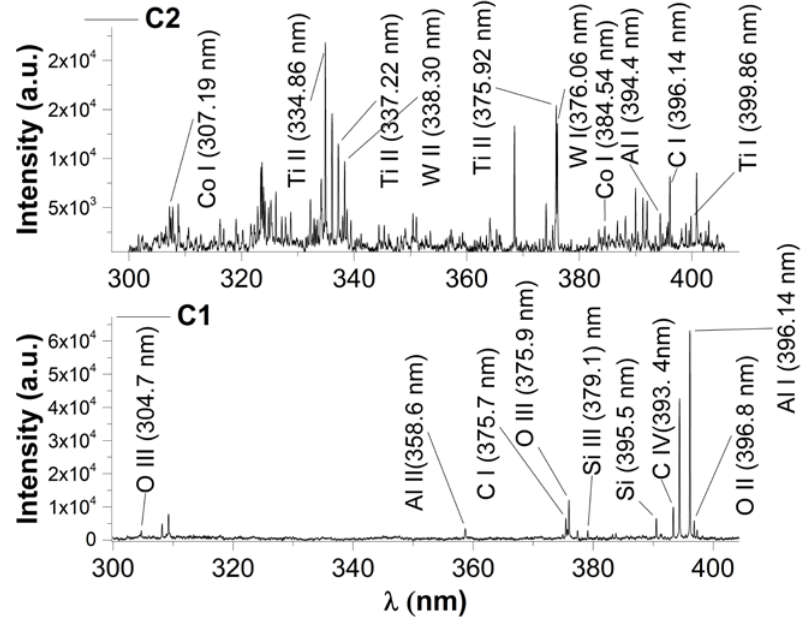
Figure 4. Optical emission spectra of the two investigated plasmas.